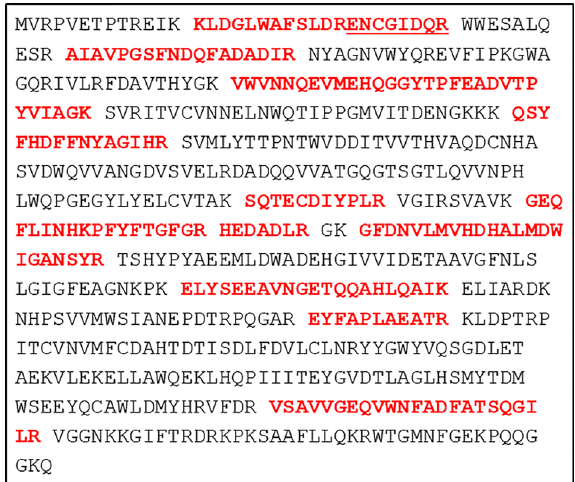
FIGURE 1 | Primary sequence of the transgene E. coli glucuronidase A with the identi fi ed peptides highlighted in bold red letters. The underlined sequence is a separate peptide generated from the longer peptide sequence with a missed trypsin cleavage site at position twelve. Otherwise, trypsin cleavage sites are indicated by a space. Each line consists of 40 amino acids.